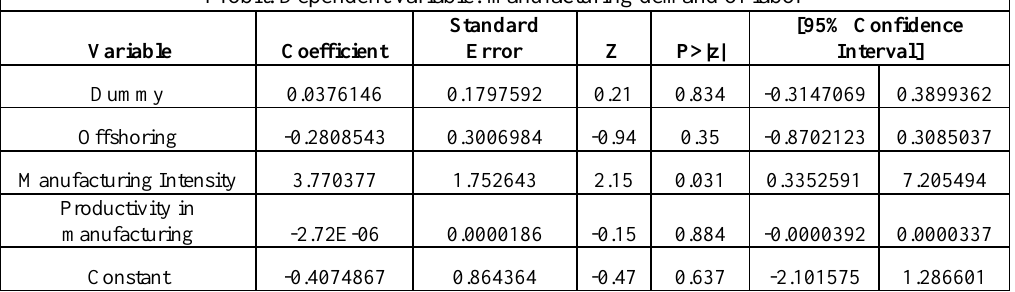
Table 10: Explaining Labor Demand in Manufacturing in Italian Provinces 2008- 2011 Probit. Dependent variable: manufacturing demand of labor Variable